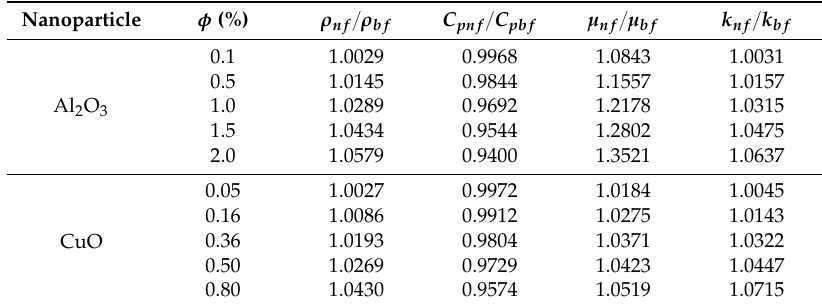
Table 2. The density ratio, specific heat ratio, viscosity ratio, and thermal conductivity ratio for the nanofluids with various particle volume fractions to base fluid (water) at 298